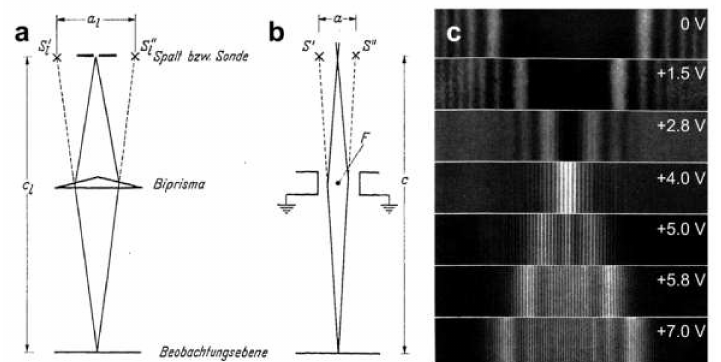
Figure 11. A biprism in an electron microscope. Ray diagrams for ( a ) an optical prism and ( b ) an electron biprism in an electron microscope. ( c ) Experimentally recorded electron biprism interference patterns with di ff erent potentials applied to the biprism, using a wire 2 µ m in diameter. Reprinted from [39] by permission from Springer Nature, copyright